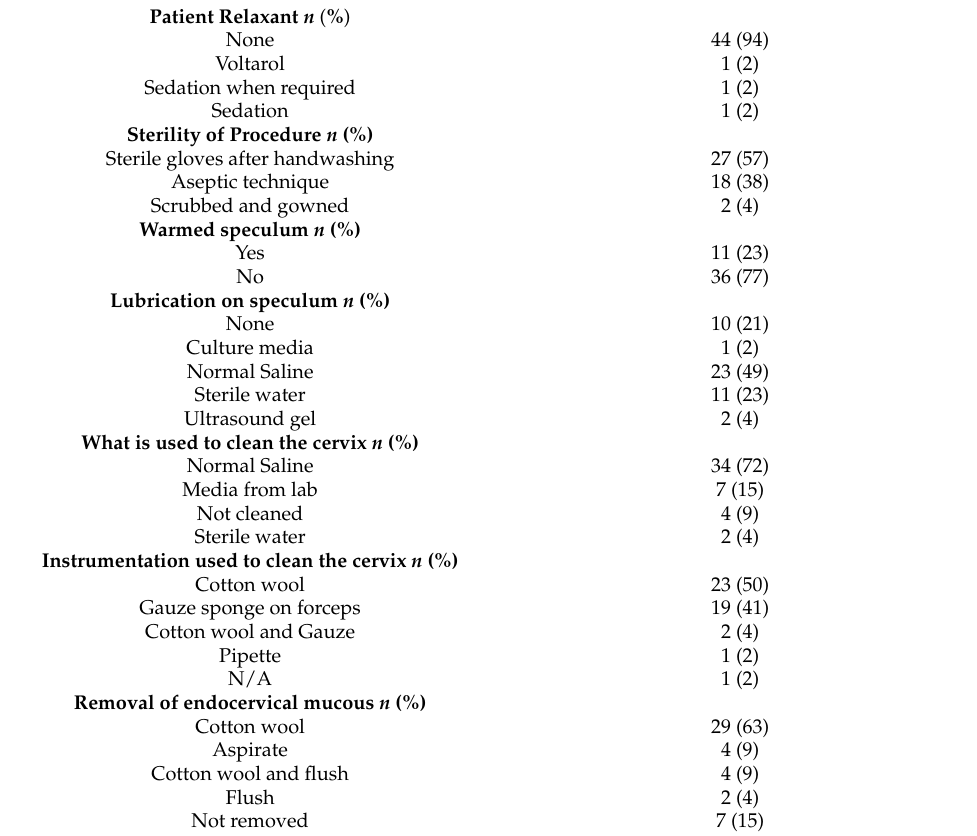
Table 4. Patient and practitioner preparation prior to